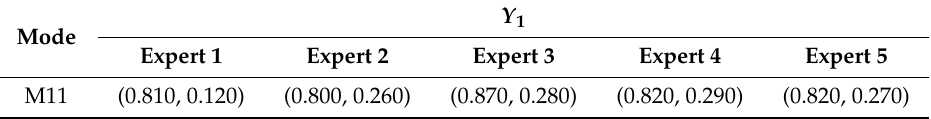
Table 8. Experts’ judgment information on the satisfaction degree of M11 mode to index Y 1